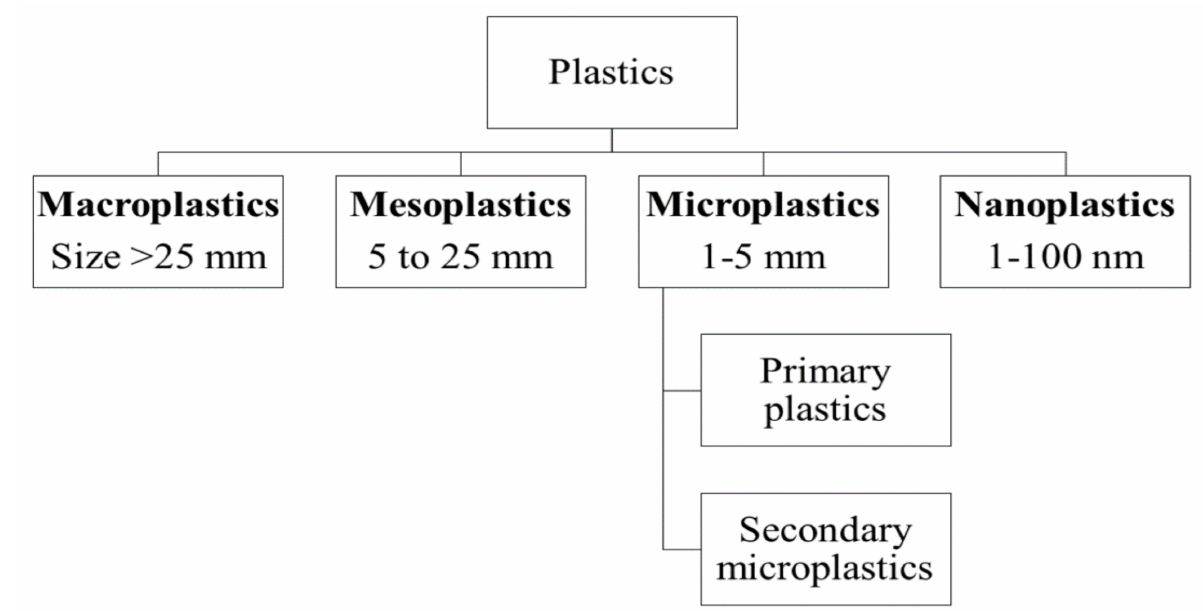
Figure 1. Various classifications of the plastics based on size.